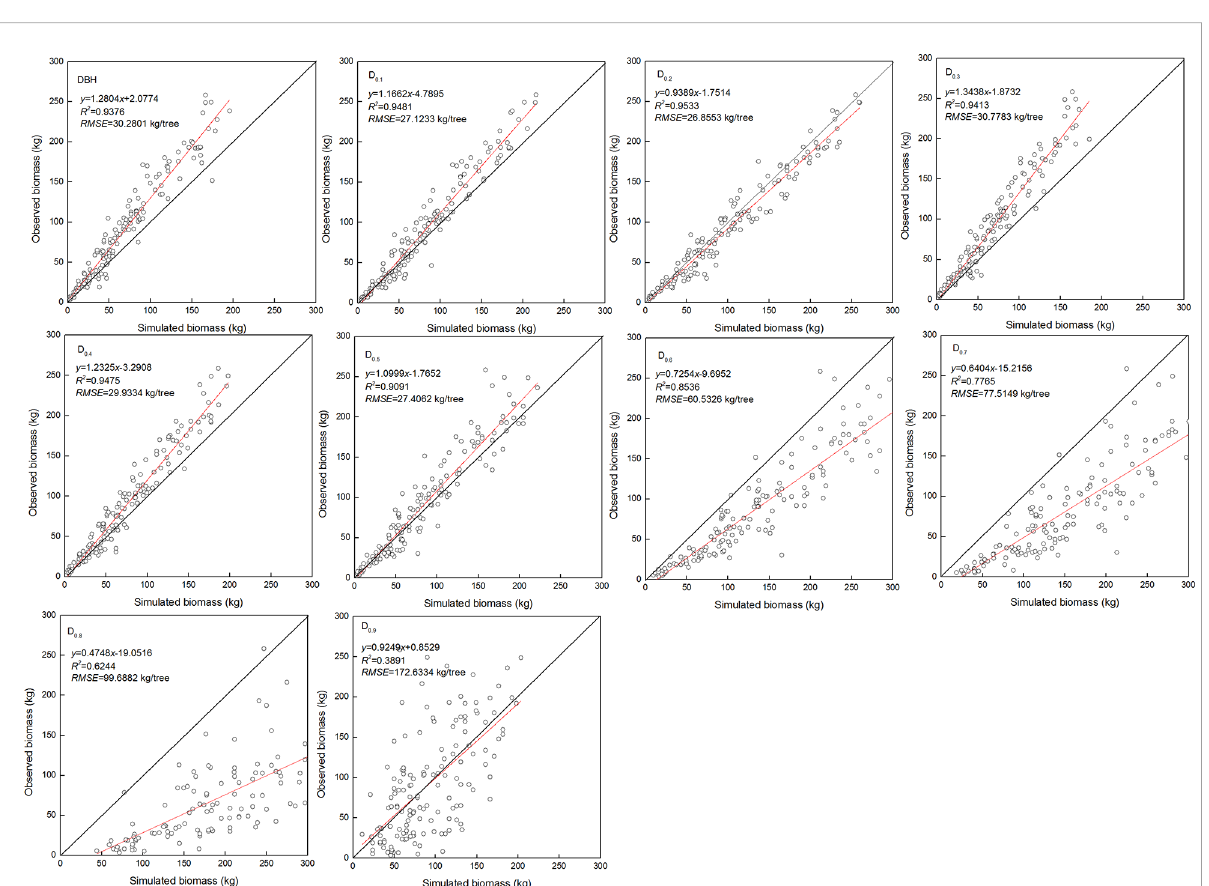
FIGURE 2 Linear relationship between observed and simulated data for stem biomass. Diameter at breast height (DBH), diameter at relative tree height (D i , i = 0.1 to 0.9), simulated values (y), observed values (x), coef fi cient of determination (R 2 ), and root mean square error (RMSE). The black and red line represents the 1:1 isoline and linear equation,